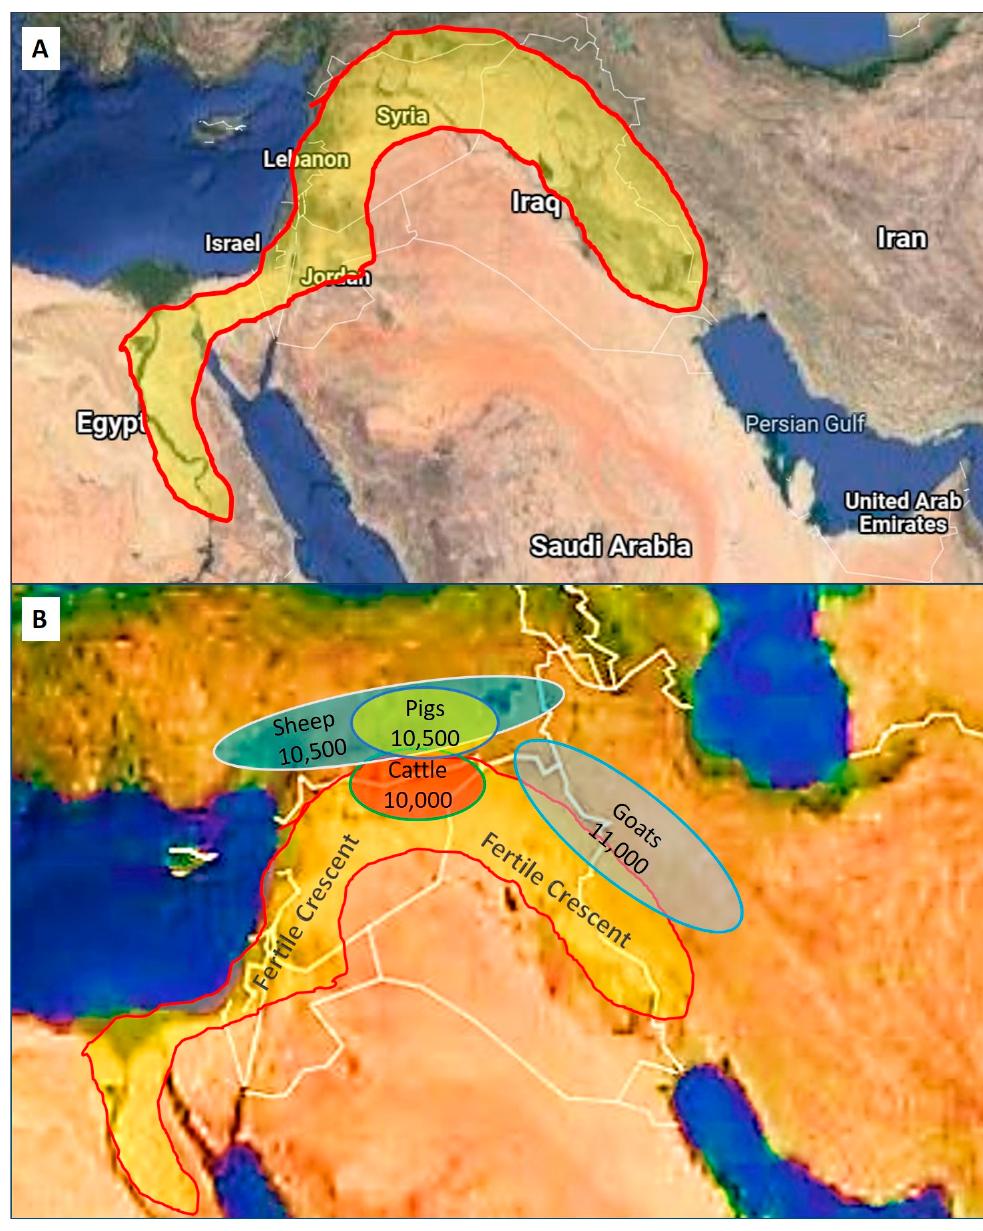
Figure 2. The Fertile Crescent and the origins of domestication. ( A ) The yellow shaded area indicates the size and location of the Fertile Crescent in an area known as Mesopotamia, which overlaps in modern times with parts of Egypt, Israel, Palestine, Syria, Turkey, Iraq, and Iran. ( B ) Shaded ovals represent the approximate areas of domestication of sheep, pigs, cattle, and goats in relation to the Fertile Crescent (after Ref. [1]). Numbers indicate the dates of initial domestication in years before the present (BP).